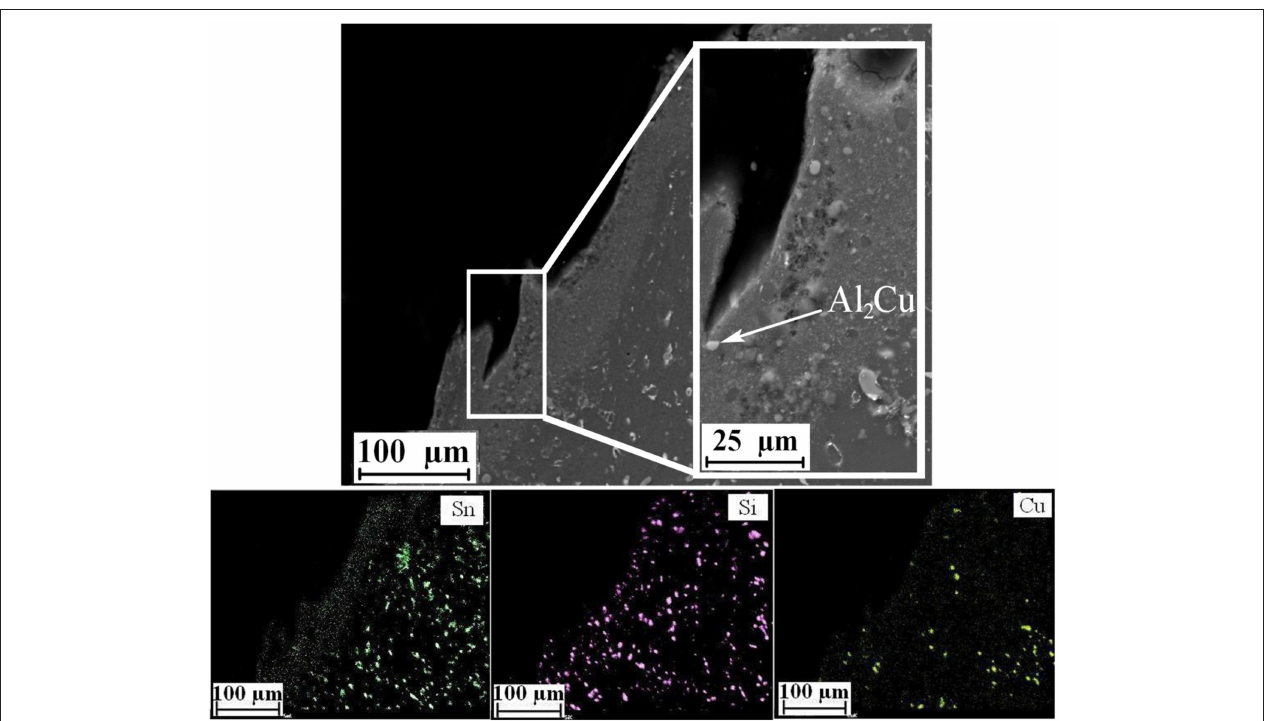
FIGURE 7 | SEM image of the transversal section surface of the block of iron-containing alloy after tribological tests without lubrication; mapping for the main alloying elements.